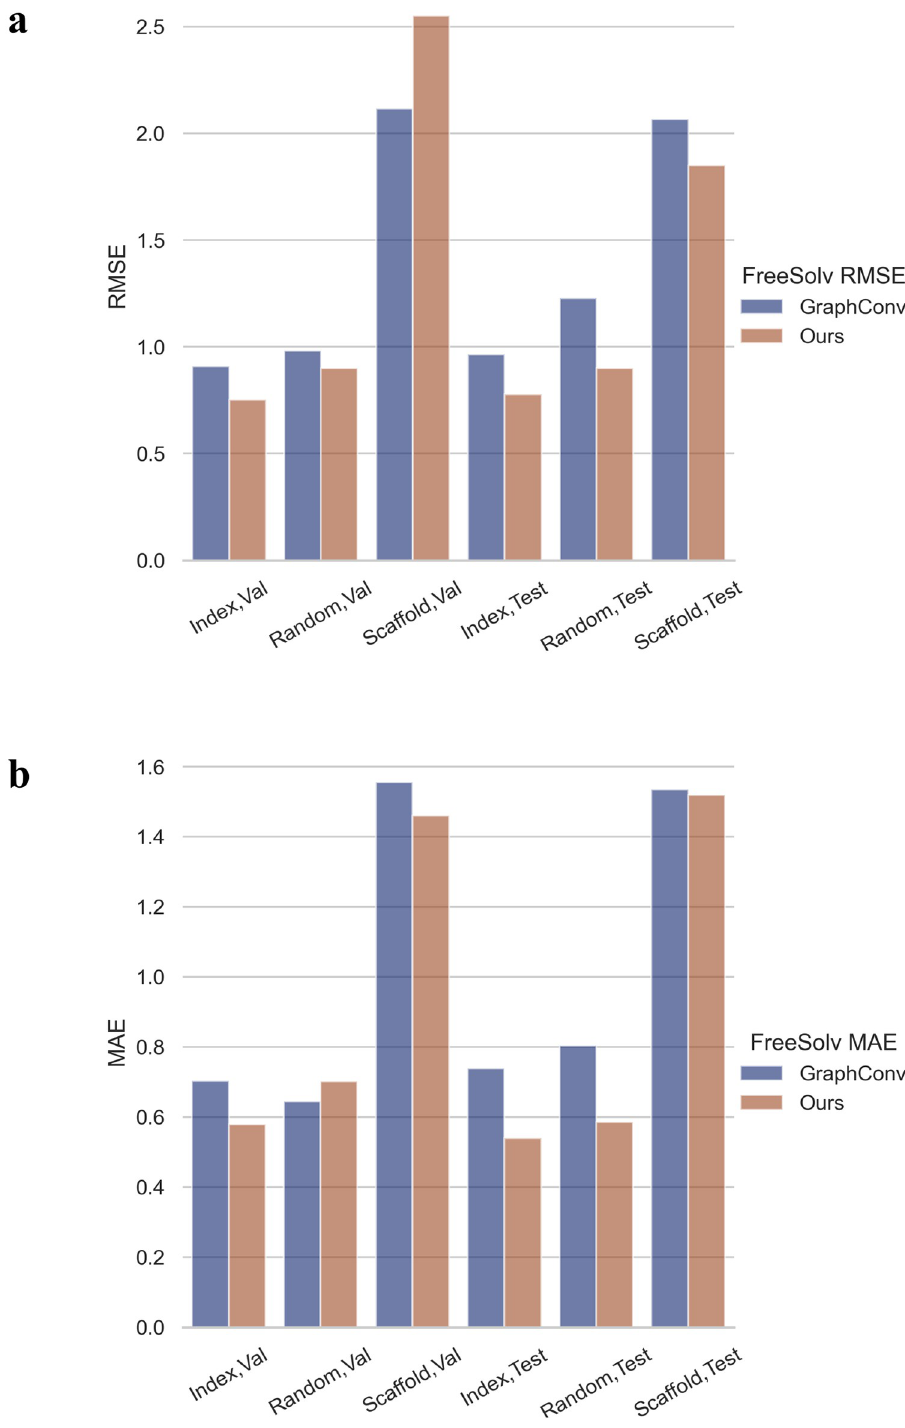
Fig 8. Performance comparison between our model and the baseline model in the regression task. a RMSE and b MAE (kcal/mol) are provided to perfectly reflect the performance of the models in the regression task of the Freesolv